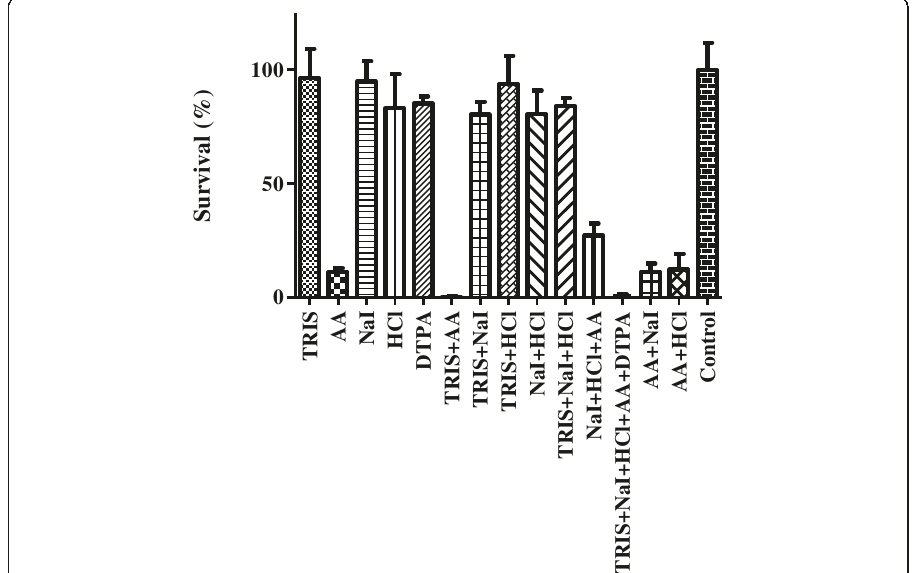
Fig. 6 Survival (%) ± SD of CA20948 after exposure to the compounds used in standard labelling procedure, n = 3. Concentration in incubation medium was; [TRIS]= 16 mmol.L − 1 , [AA] = ascorbic acid, 3.4 mmol.L − 1 , [NaI] = 3.6 mmol.L − 1 , [HCl] = 3.6 mmol.L − 1 and [DTPA] = 6.1 × 10 − 3 mmol.L −